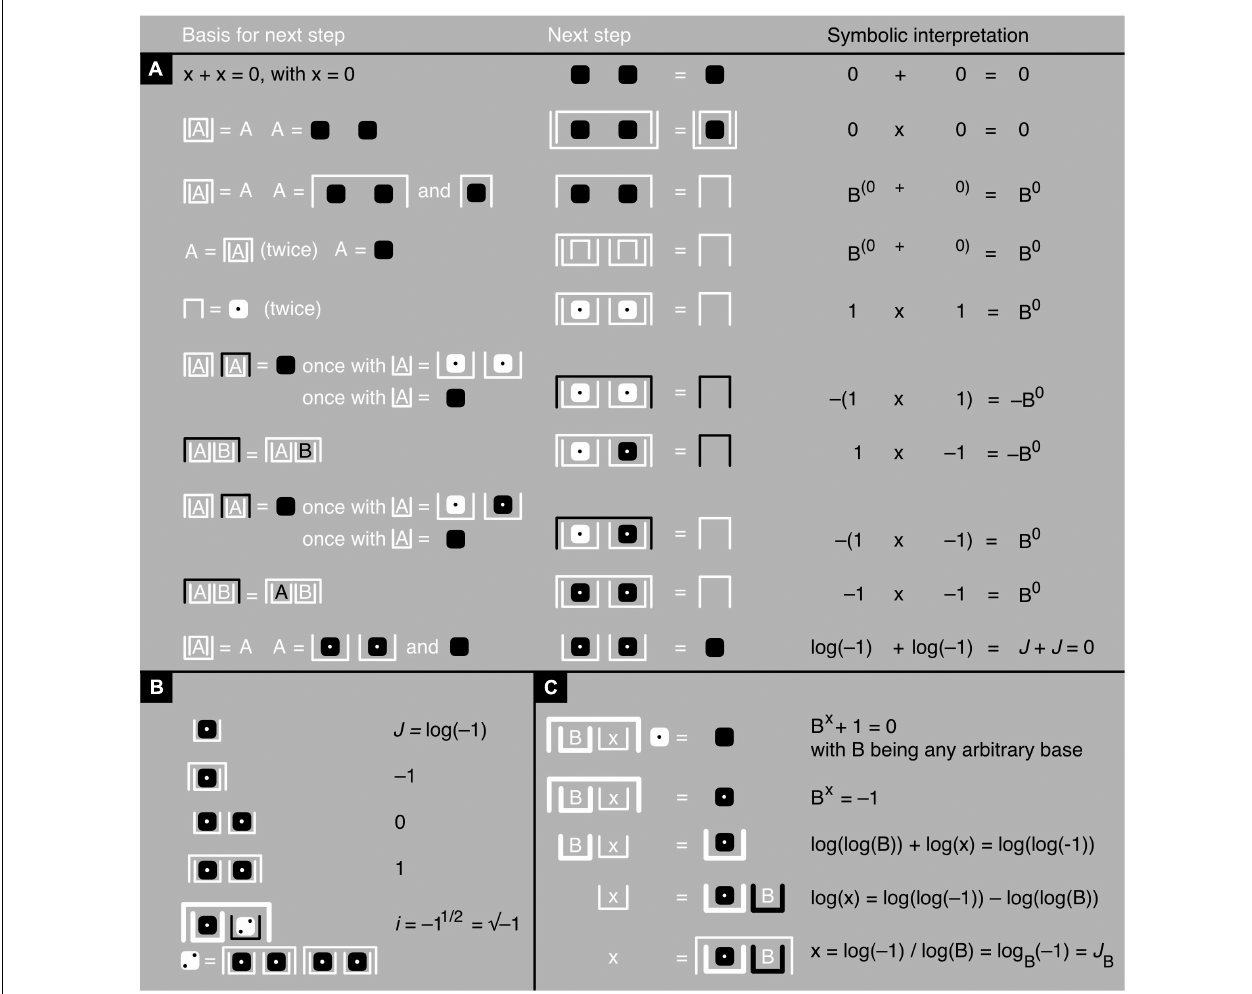
FIGURE 10 | Imaginary number J . (A) An iconic proof of the fact that x = J is a solution of the equation x + x = 0, with, based on Figure 7 axioms and theorems, the justification of each next step toward a problem’s solution (left), the step itself (middle), and a symbolic interpretation (right). (B) An iconic definition of J and iconic definitions, exclusively in terms of J , of the other candidate foundational numbers: –1, 0, 1, and i . (C) An iconic proof of the fact that x = J B solves the equation B x + 1 = 0, with B being any arbitrary base, which for example can be e . Note that mixing real and imaginary numbers is subject to restrictions (Bricken, 2021), and to prevent inconsistencies, the last axiom in Figure 7 is not used